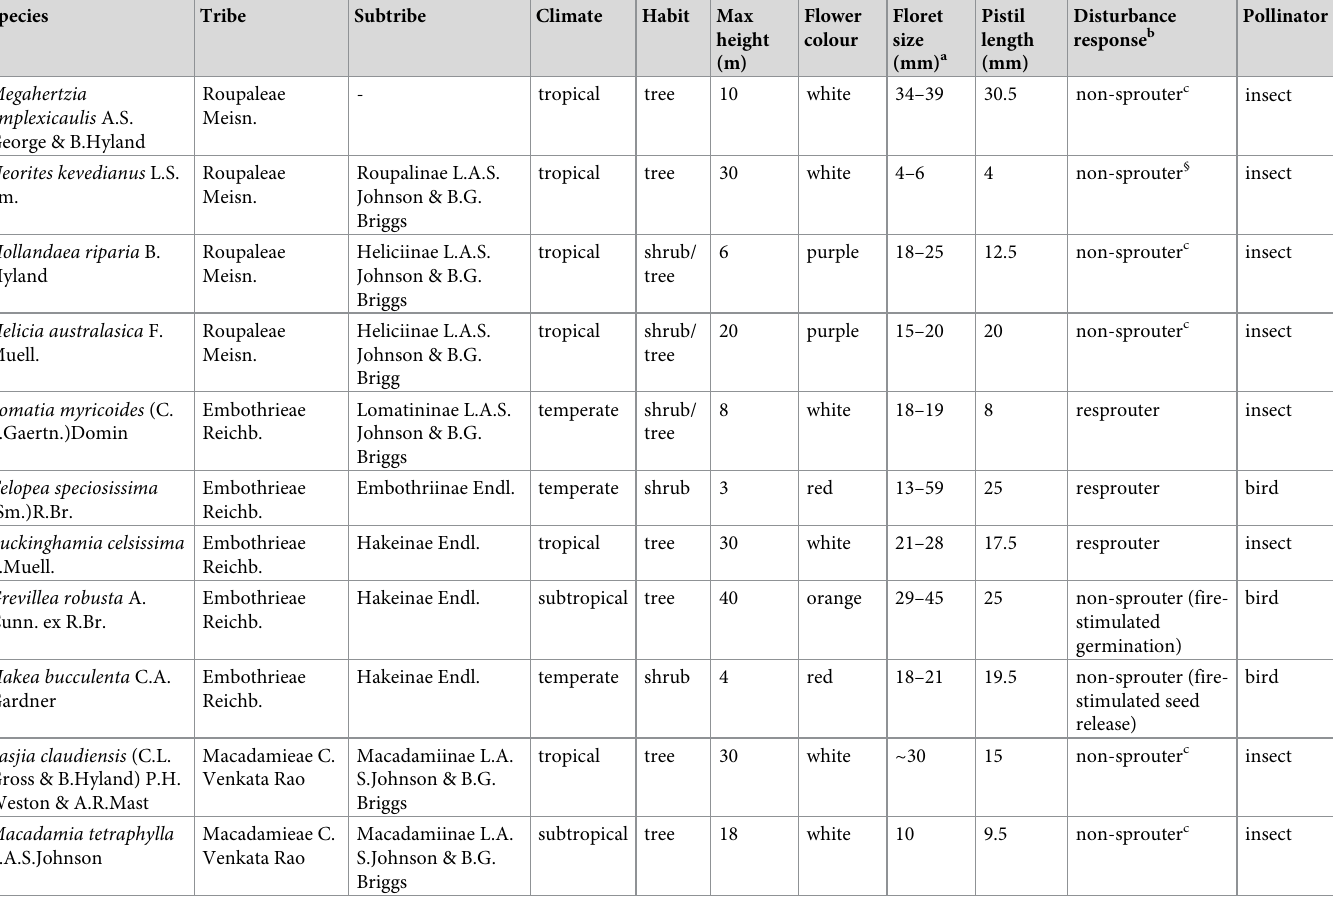
Table 1. Details of eleven Proteaceae species in this study (in taxonomic order based on